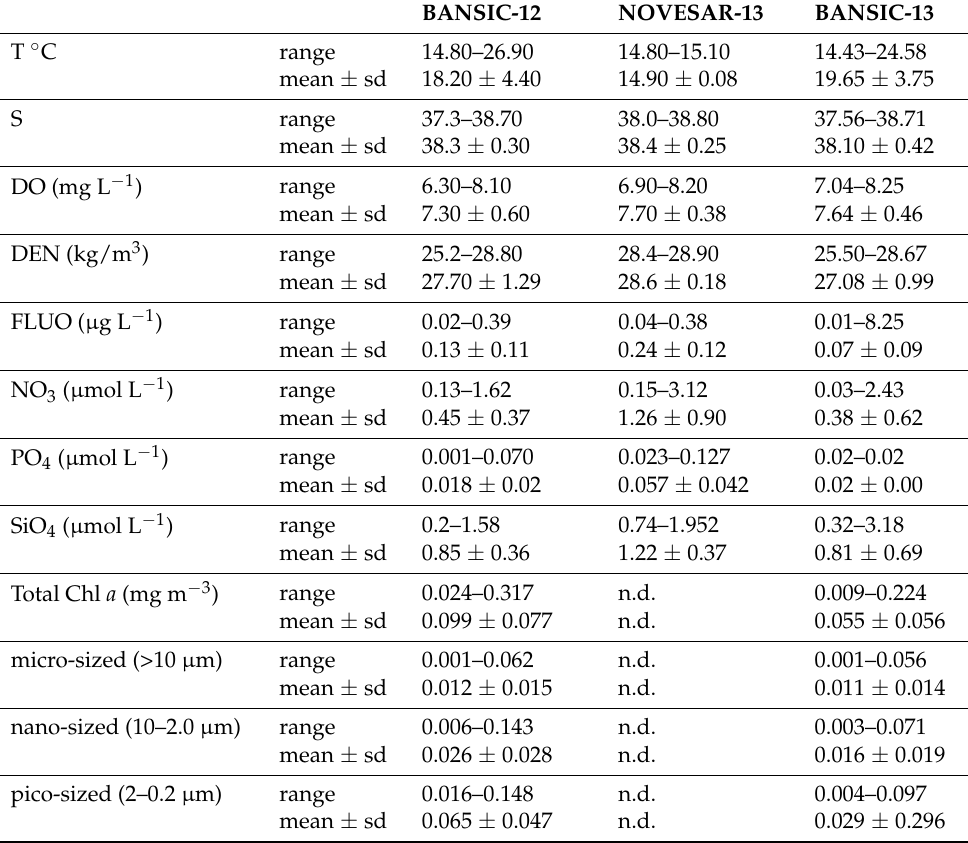
Table 2. Ranges of variation, means and standard deviations of temperature (T ◦ C), salinity (S), dissolved oxygen (DO), density (DEN), fluorescence (FLUO), nitrates (NO 3 ), phosphates (PO 4 ), silicates (SiO 4 ) and total and fractionated Chl a . n.d. = not